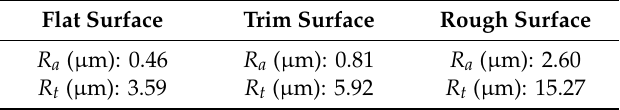
Table 3. Surface roughness following di ff erent